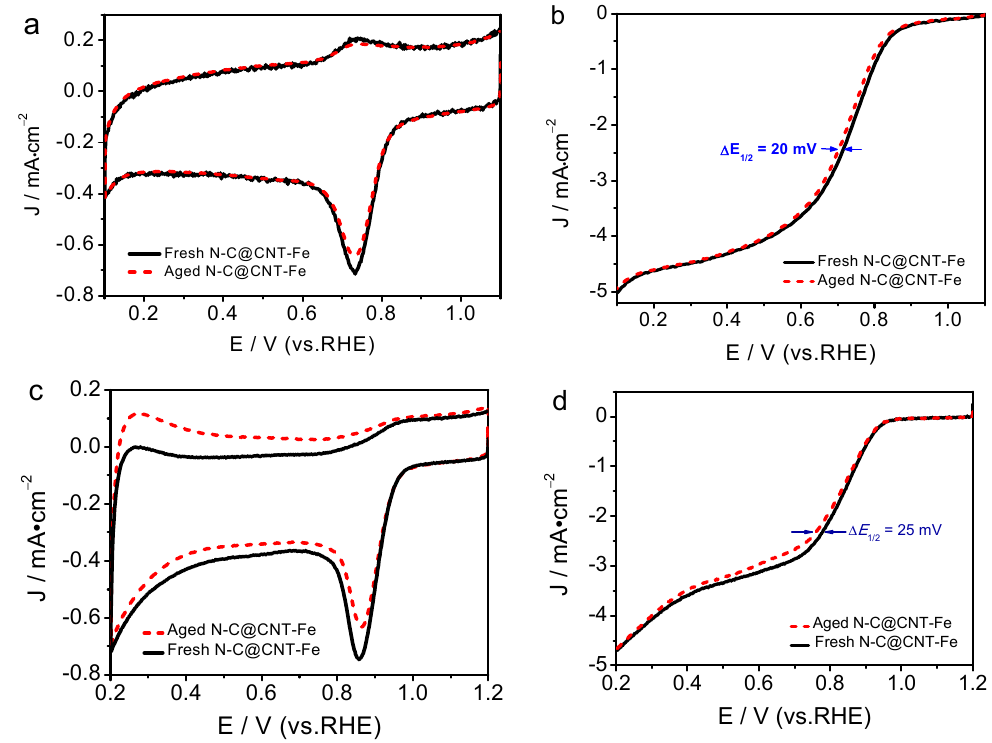
Figure 6. Cyclic voltammetry curves of N-C@CNT-Fe before and after accelerated aging tests (AAT) in O 2 -saturated 0.1 mol·L − 1 HClO 4 ( a ) and 0.1 mol·L − 1 KOH solution ( c ). LSV curves of N-C@CNT-Fe before and after AAT in O 2 -saturated 0.1 mol·L − 1 HClO 4 ( b ) and 0.1 mol·L − 1 KOH solution ( d ) at a rotation rate of 1600 rpm.